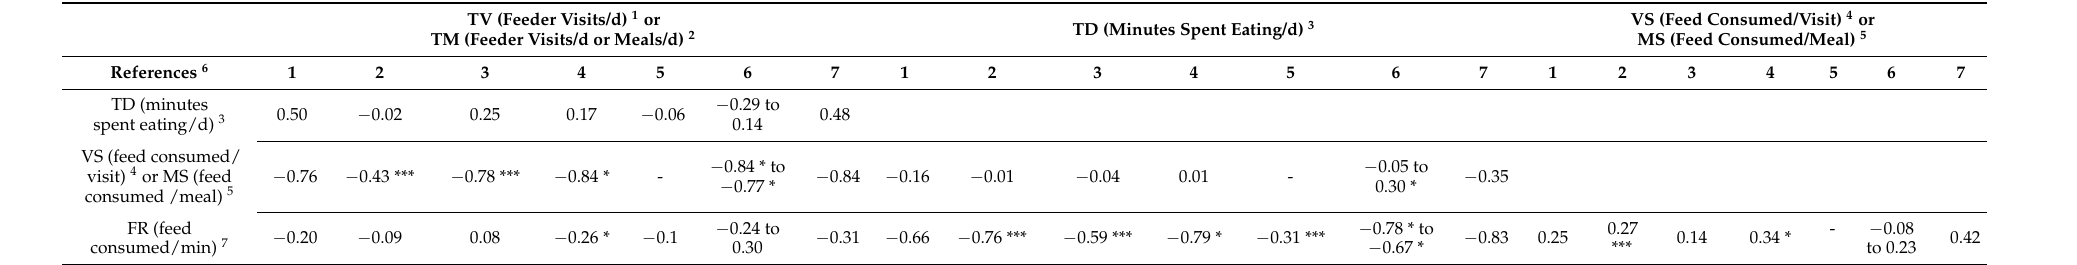
Table 6. Correlation results between feeding behaviour habits obtained in different